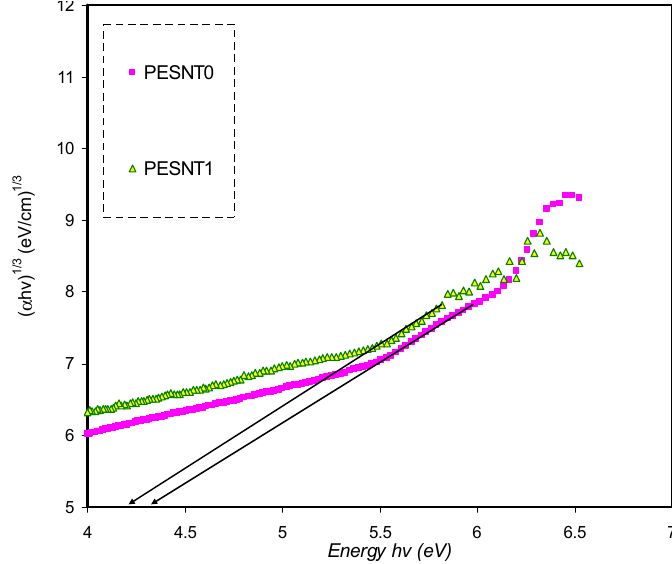
Figure 9. ( α h υ ) 2 / 3 in opposition to energy of photon for pure PEO (PESNT0) and PESNT1 composite samples.